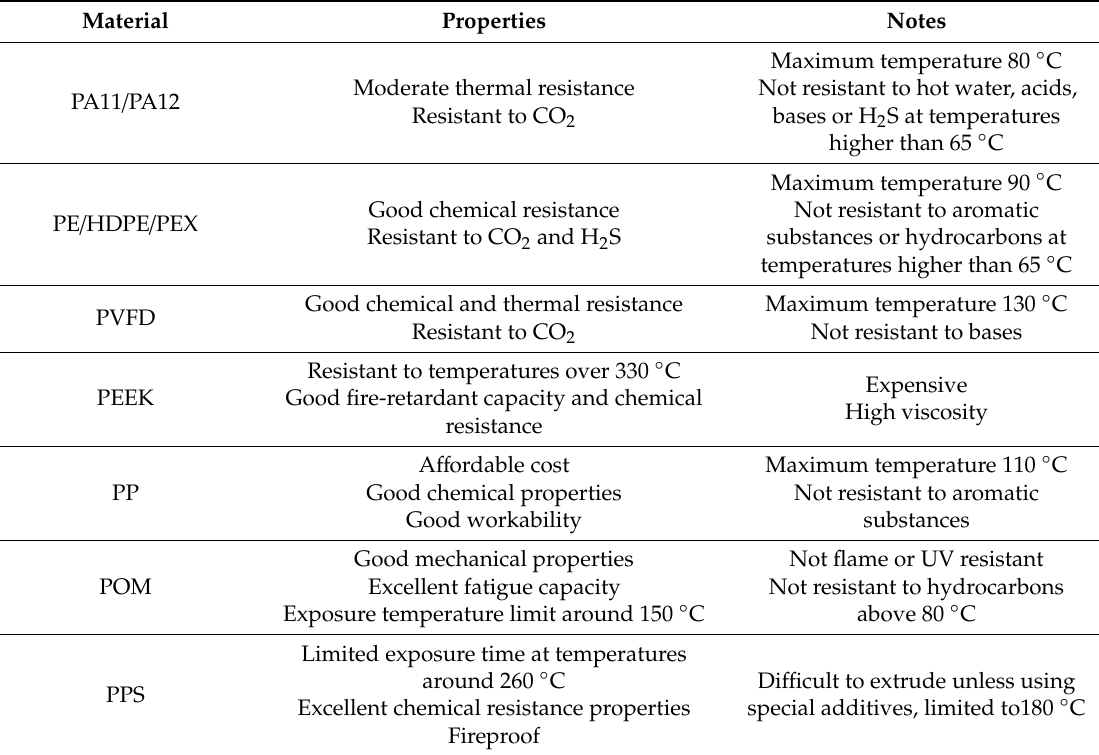
Table 2. Properties of thermoplastic used in oil and gas applications [22].